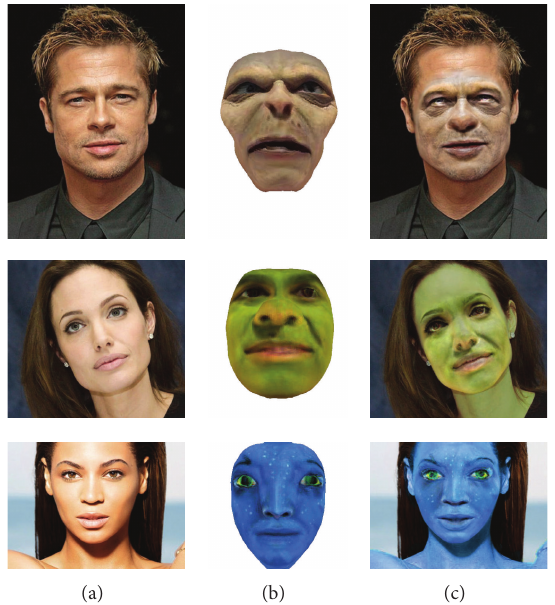
Figure 13: The results of using our approach in an entertainment application. From left to right: the input human photograph, the selected AS-face, and the final result. Each 3D HI-face is created from a photograph of the celebrity by using FaceGen [43]. Note that the synthesized faces are only the facial part but we adjust all the skin parts of the celebrities to match the AS-face styles. Also, some faces are rotated to fit to the photograph face